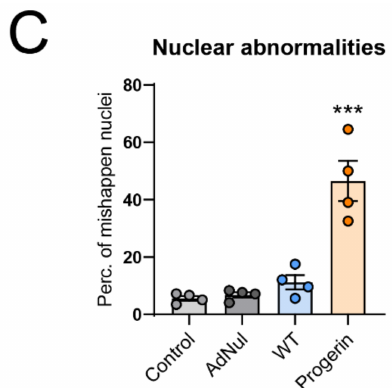
Figure 1. Expression and localization of exogenous lamin A and progerin. Early-confluent human coronary artery endothelial cells (HCAECs) were transduced or not with Flag-tagged recombinant adenovirus containing WT-prelamin A or progerin for 72 h, or with an empty vector (AdNul). ( A ) Western blot analysis of lamin A and C and progerin. β -actin was used as a loading control. Representative picture of n = 4 experiments. ( B ) Representative pictures of transduced HCAECs stained with Flag (green) and lamin-A (red) antibodies. Cells were observed by confocal microscopy at 100 × magnification. Examples of misshapen nuclei are indicated with a white arrow. ( C ) Quantification of misshapen nuclei as percentage of total nuclei. Data are expressed as the mean ± standard error of mean (SEM) and statistical di ff erence is determined using analysis of variance (ANOVA) followed by a Dunnett post hoc test. *** p < 0.001 vs.